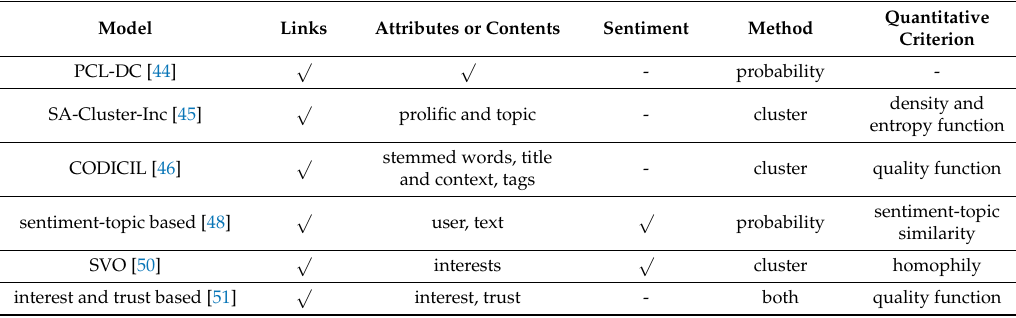
Table 3. Comparison of the Main Algorithms